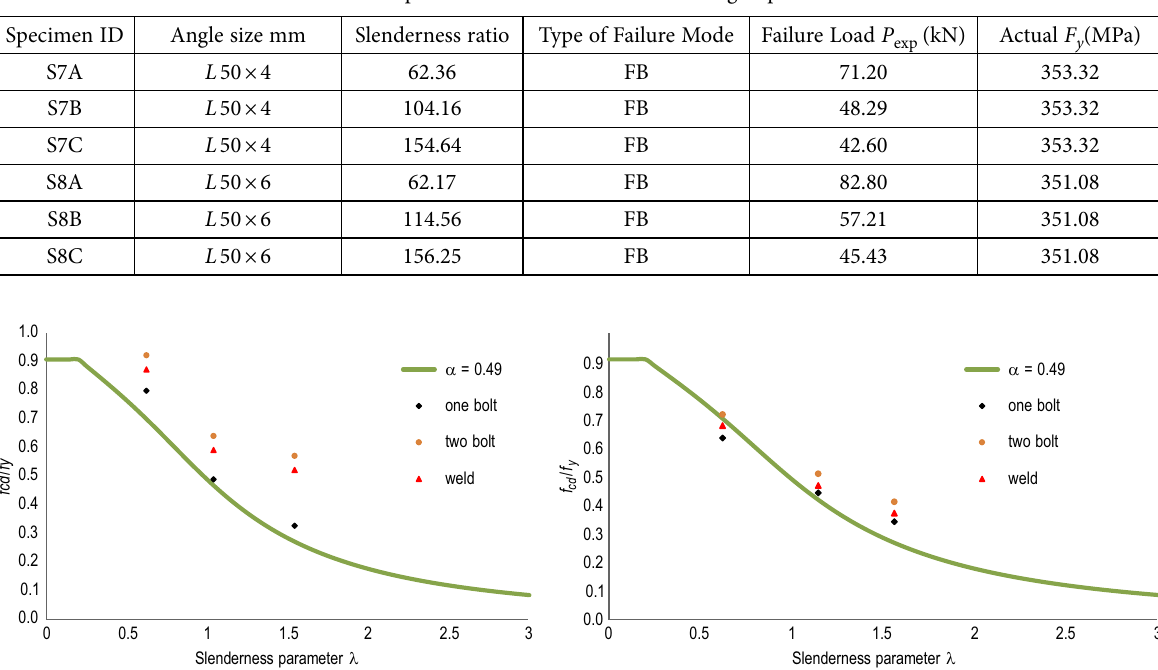
Fig.14. Comparisons of test result for L 50 × 4 with IS 800-2007 curves ( F